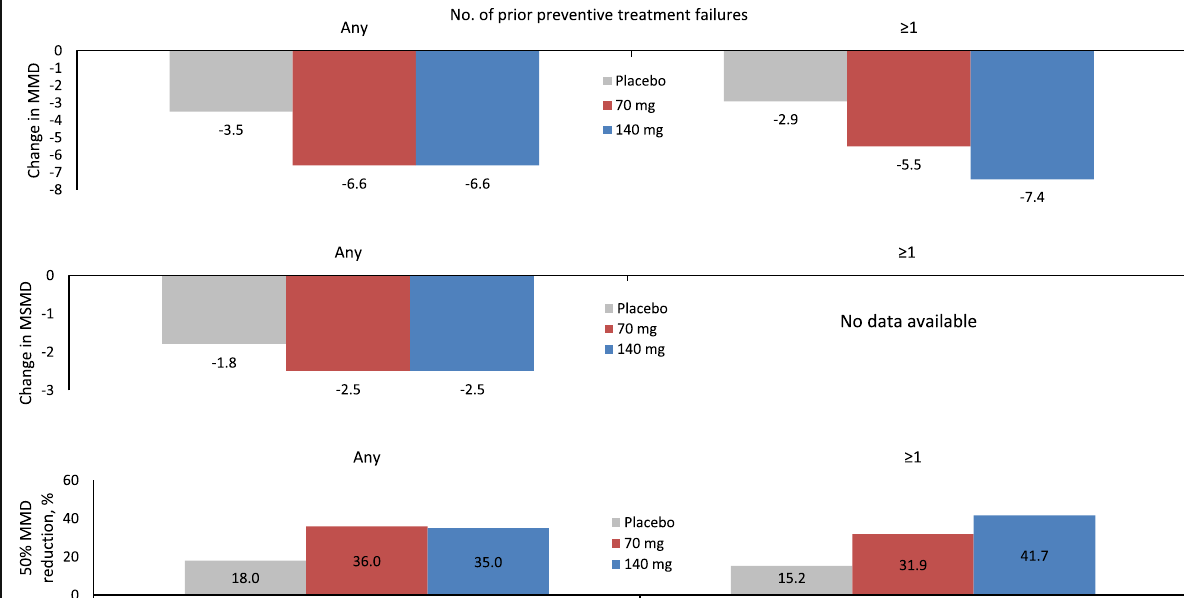
Fig. 3 Patients with chronic migraine and medication overuse: effect of erenumab on monthly migraine days, monthly migraine-specific medication days, and 50% reduction in monthly migraine days from baseline according to prior preventive treatment failures in the NCT02066415 trial [12,